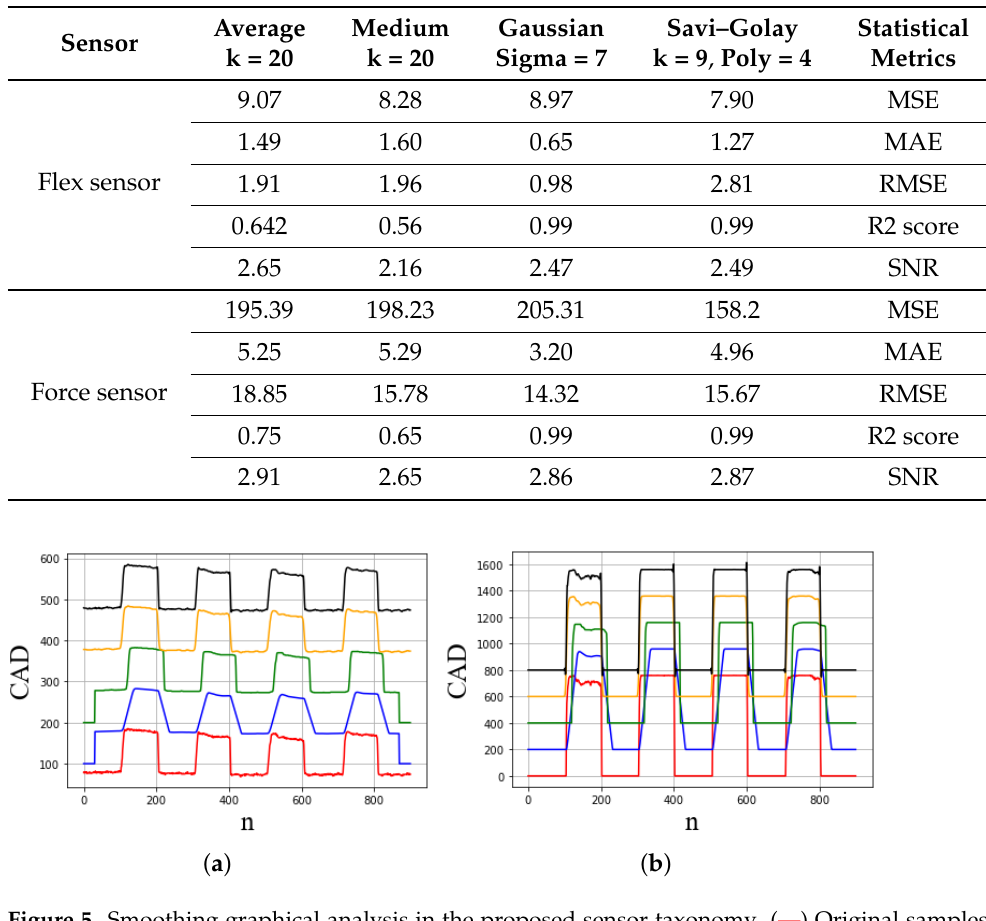
Figure 5. Smoothing graphical analysis in the proposed sensor taxonomy. ( — ) Original samples. ( — ) Average filter. ( — ) Medium filter. ( — ) Gaussian filter. ( — ) Savi–Golay filter. ( a ) FLEX sensor. ( b ) FORCE